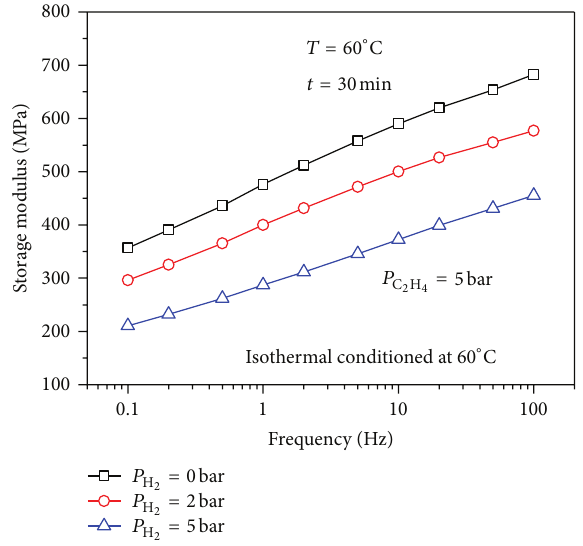
= C 2 H 4 time = 30 polymerization